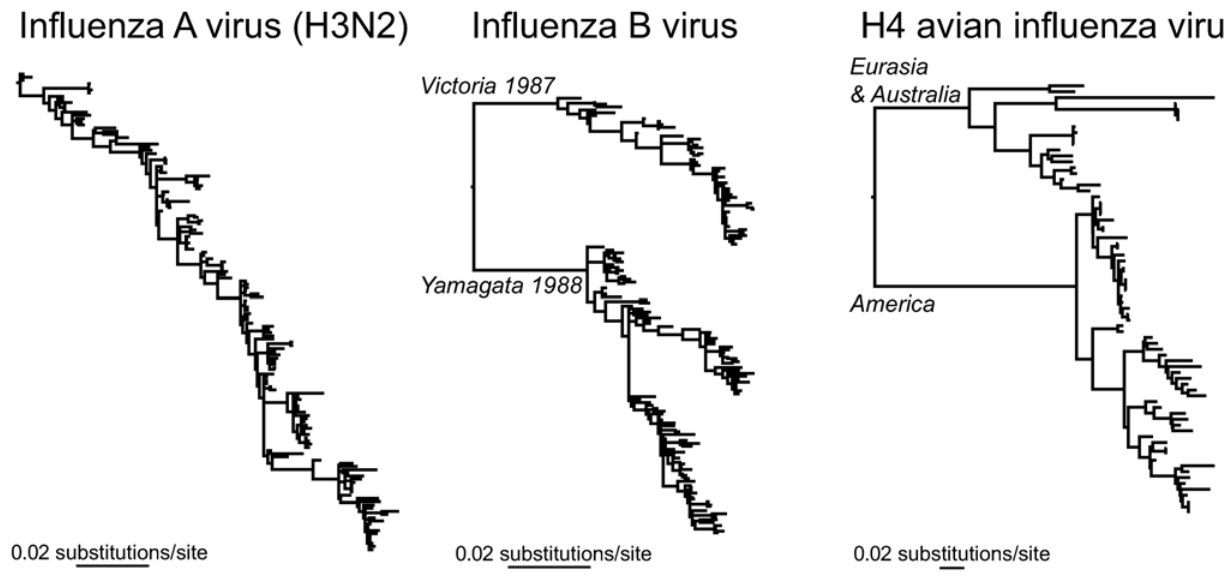
Figure 2. Phylodynamic patterns of human and avian influenza viruses. The left diagram shows the phylogeny of the hemagglutinin (HA) gene of human H3N2 influenza A viruses sampled between 1985 and 2005, revealing the ‘‘ladder-like’’ branching structure indicative of antigenic drift. By comparison, the phylogeny of the HA gene of human influenza B virus sampled over the same interval (center diagram) shows the co- circulation of the antigenically distinct ‘‘Victoria 1987’’ and ‘‘Yamagata 1988’’ lineages, as well a shorter length from root to tip, reflecting a lower rate of evolutionary change. Finally, the phylogeny for the HA gene of H4 avian influenza virus (right diagram) reveals the deep geographic division between the Eurasian and Australian versus North American lineages of this